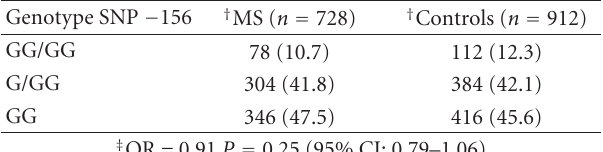
Table 2: Frequency distribution of OPN-156G/GG genotypes in MS patients and healthy